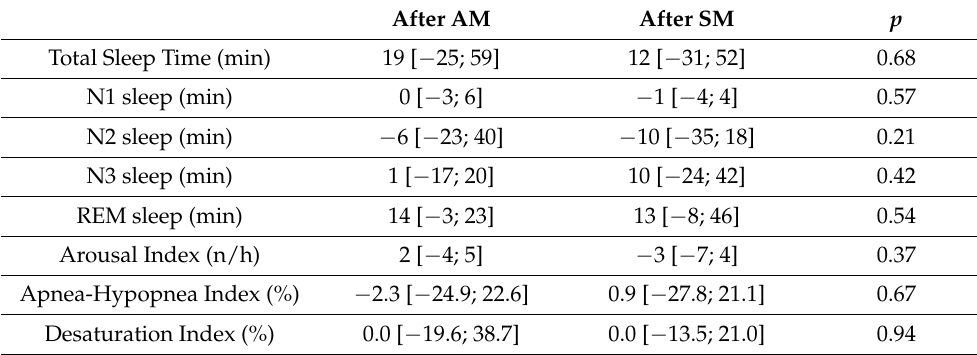
Table 2. Variation of polysomnographic data after manipulation in OSAS